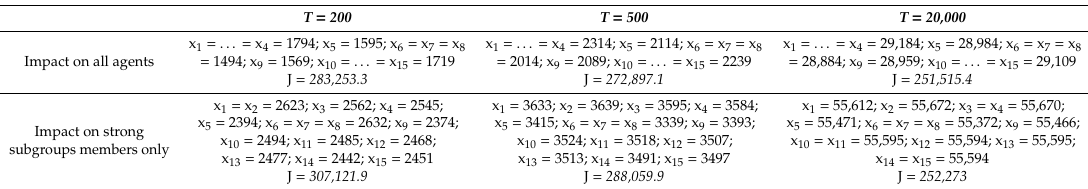
Table 2. Resulting opinions and payo ff s in model example.